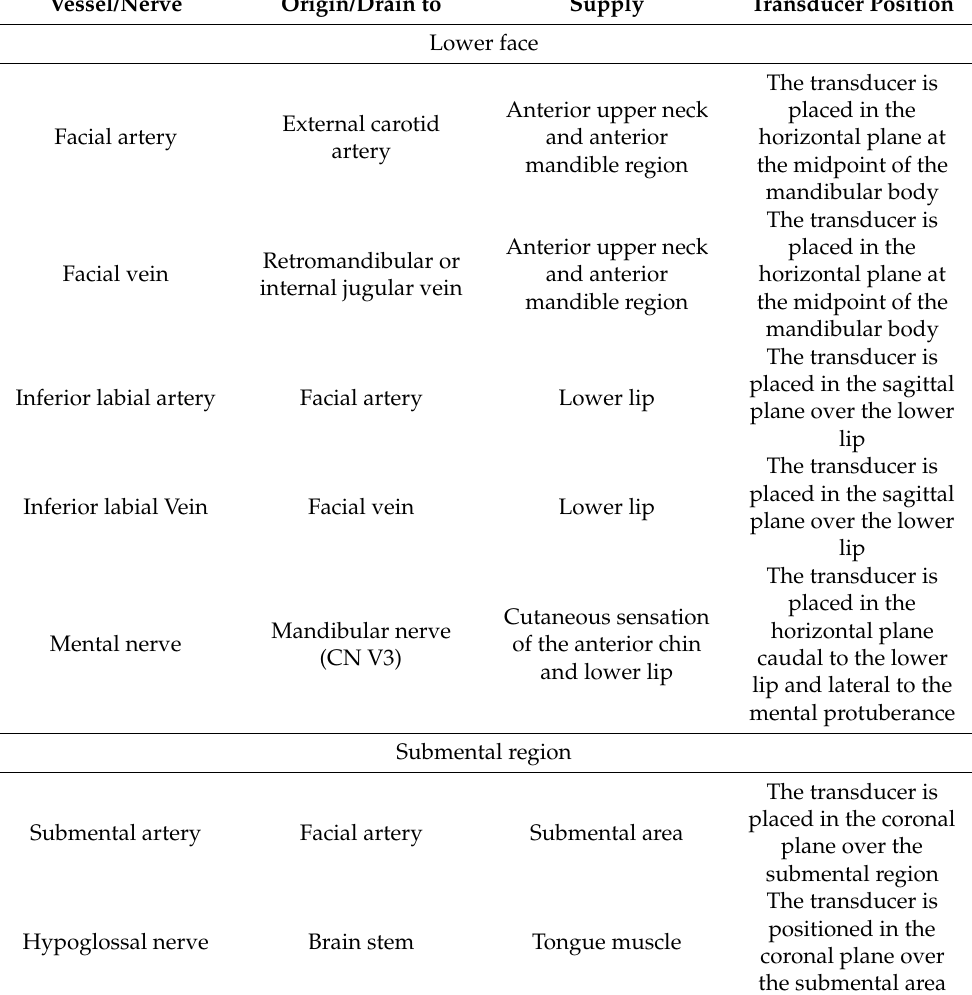
Table 3. Summary of the anatomy and scanning techniques for the neurovascular structures over the lower face and submental region.